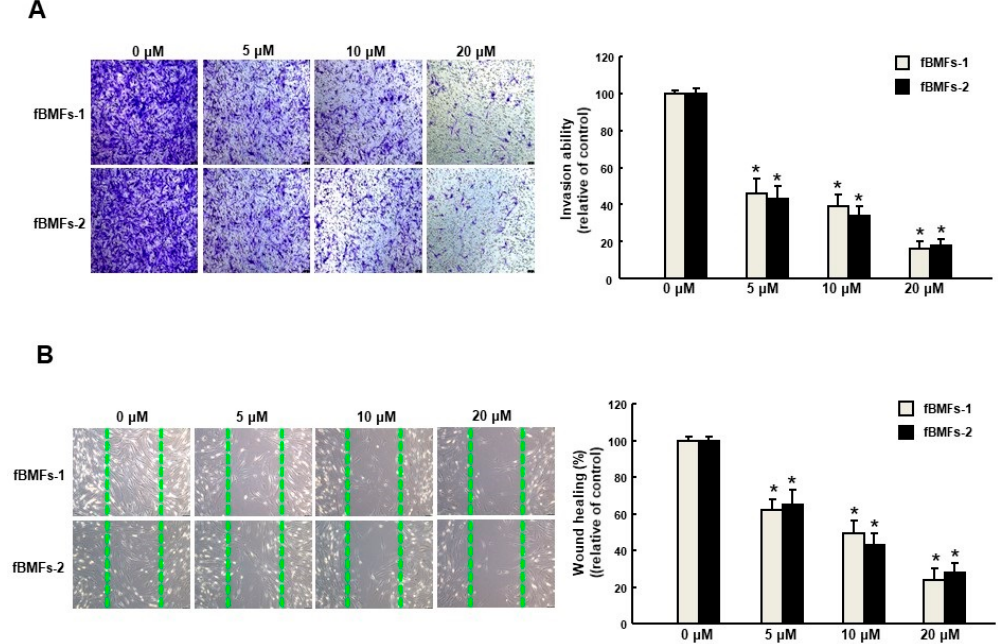
Figure 5. Arctigenin suppresses the myofibroblast activity of fBMFs. ( A ) Invasion and ( B ) wound healing in fBMFs treated with various concentrations of arctigenin. The experiments were repeated three times, and representative results are shown. The results are means ± SD. * p < 0.05 as compared with the non-arctigenin-treated group. Magnification, ×100.